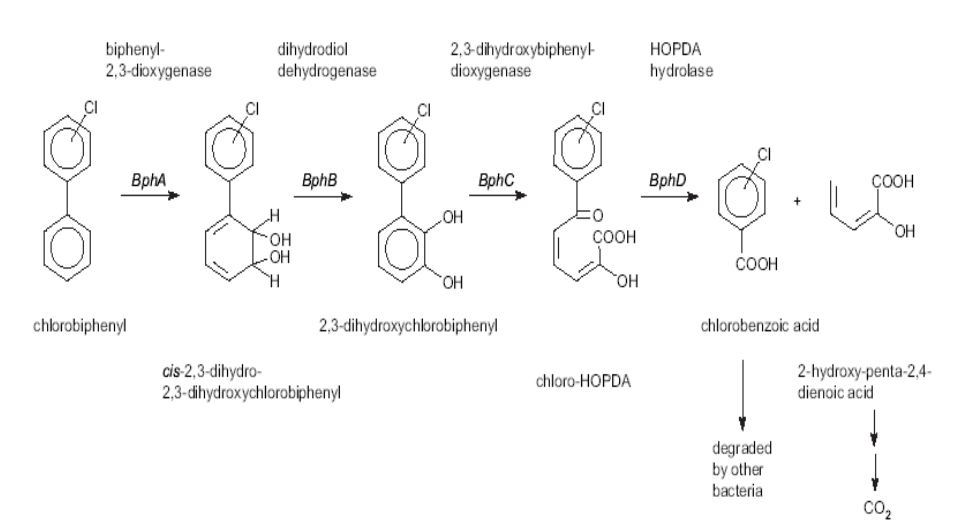
Figure 2. Biphenyl ( bph ) upper-pathway of aerobic PCB degradation [89,100]. Intermediates such as hydroxylated chlorobiphenyls [102] and chlorobenzoic acids [13,19,103] been used as targets in developing biosensors for monitoring PCB